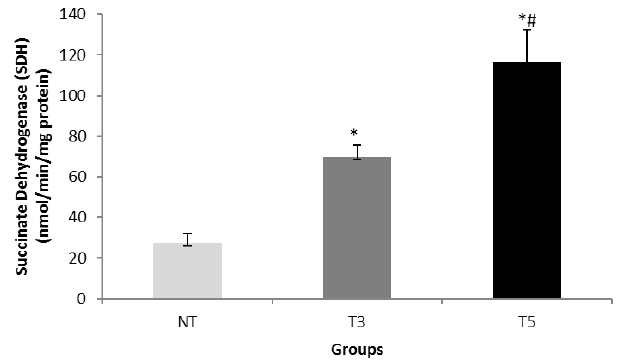
Figure 1 : Succinate Dehydrogenase (SDH) levels measure in the quadríceps in healthy mice trained in a treadmill for three-time (T3) or five-time (T5) per week. The values are presented as Means±SEM and the results expressed in nmol/min mg protein. (*) Significant difference in relation to the UT, T5 # and T3 p<0.05.